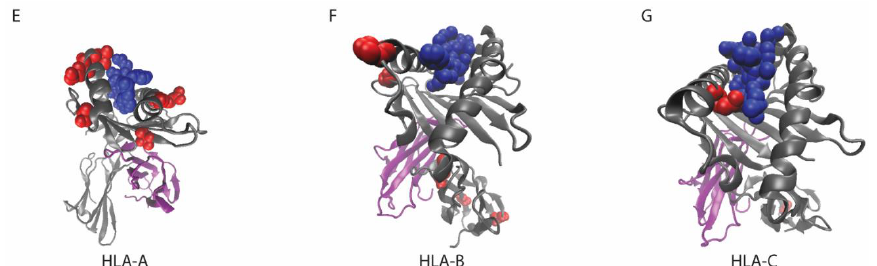
Figure 2. Mutation frequency and localization of MHC class I complex and related proteins. ( A ) mutation frequency of members of the MHC. HLA-A, B, and C, are paralogs of the MHC heavy chain, and β -2 microglobulin ( B2M ) forms the MHC light chain. 8% of HNSCC tumors have a somatic mutation in one or more HLA gene, and 2% have a mutation in B2M . 21% of all tumors have a somatic mutation in one or more genes associated with either MHC class I transcriptional regulation or the antigen loading pathway. NFKB , IRF1 / 2 , SP1 , NLRC5 , RFX1 , and USF1 are each transcription factors that have been shown to interact with the HLA promoter region in various cell types [57 – 59]. The transcription factors that regulate MHC class I have not been described in HNSCC. BCAP31 is necessary for shuttling the MHC class I from the ER to the GA, and each of the remaining proteins has a role in MHC class I folding and neoantigen loading within the ER [60 – 63]. Transcriptional regulation of the MHC class I has been shown to depend on a complex network of cis and trans-acting regulation, so a comprehensive list of transcription factors with a defined role in MHC class I regulation has not been fully determined [64]. ( B – D ) Localization of mutations detected in HNSCC patients in HLA-A ( B ), HLA-B ( C ), and HLA-C ( D ). Black dots represent a nonsense mutation; green dots represent a missense mutation. Peptide domains are marked on each MHC class I peptide. Green domain: MHC class I alpha 1 and 2 domains. Red: C1-set domain. Blue: C terminal domain. ( E – G ) Location of somatic missense mutations within the HLA protein detected in HNSCC tumors. The HLA protein consists of three α domains: α -1 and -2 contain the antigen binding groove, while the α -3 domain interacts with β -2 microglobulin. Purple: β -2 microglobulin. Grey: HLA heavy chain, including the α -1 – 3 domains. Blue: neoantigen peptide, located in the antigen binding groove. Red: amino acids that are subject to somatic missense mutation in one or more HNSCC patient. Mutations in HLA-A ( E ) are localized to the antigen binding groove, eight total missense mutations. Mutations in HLA-B ( F ) are present in each α domain, seven total missense mutations. Mutations in HLA-C ( G ) are present in the α -3 domain as well as the antigen binding groove, two total missense mutations. Mutation data retrieved from the TCGA PanCancer Atlas.